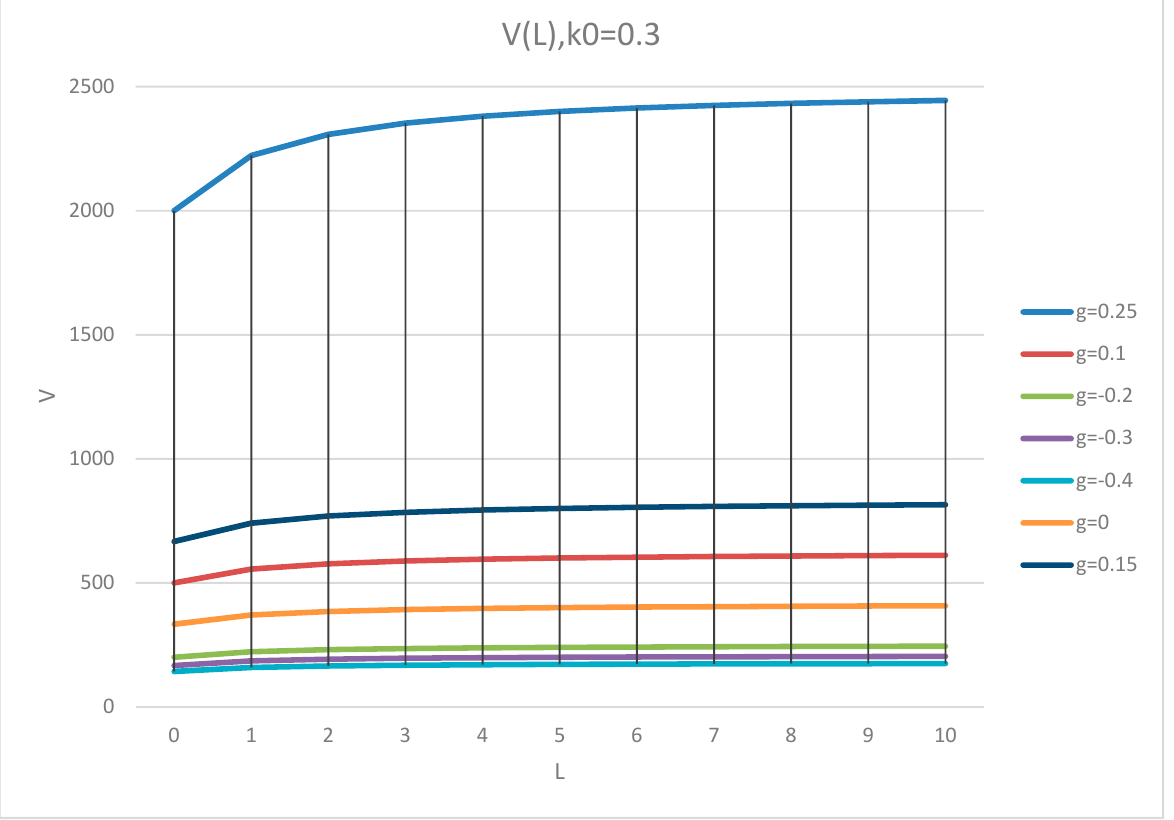
Figure 7. Dependence of company value V on leverage level L in Generalized Modigliani–Miller theory (GMM theory) at k 0 = 0.3 and g = 0; 0.1; 0.15;0.25; − 0.2; − 0.3; − 0.4.